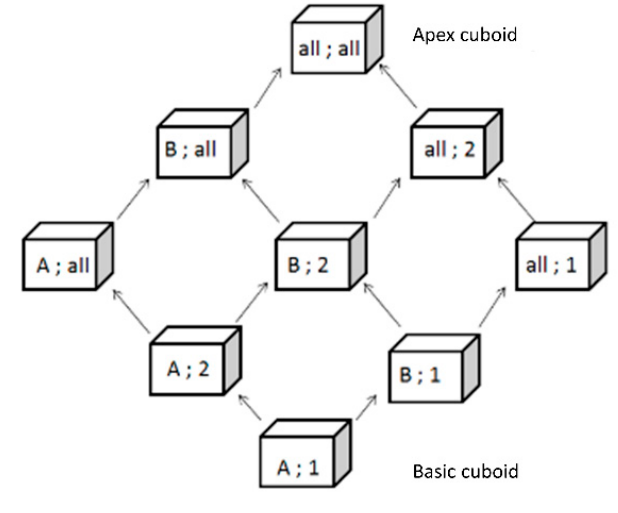
Figure 7. A lattice of cuboids.